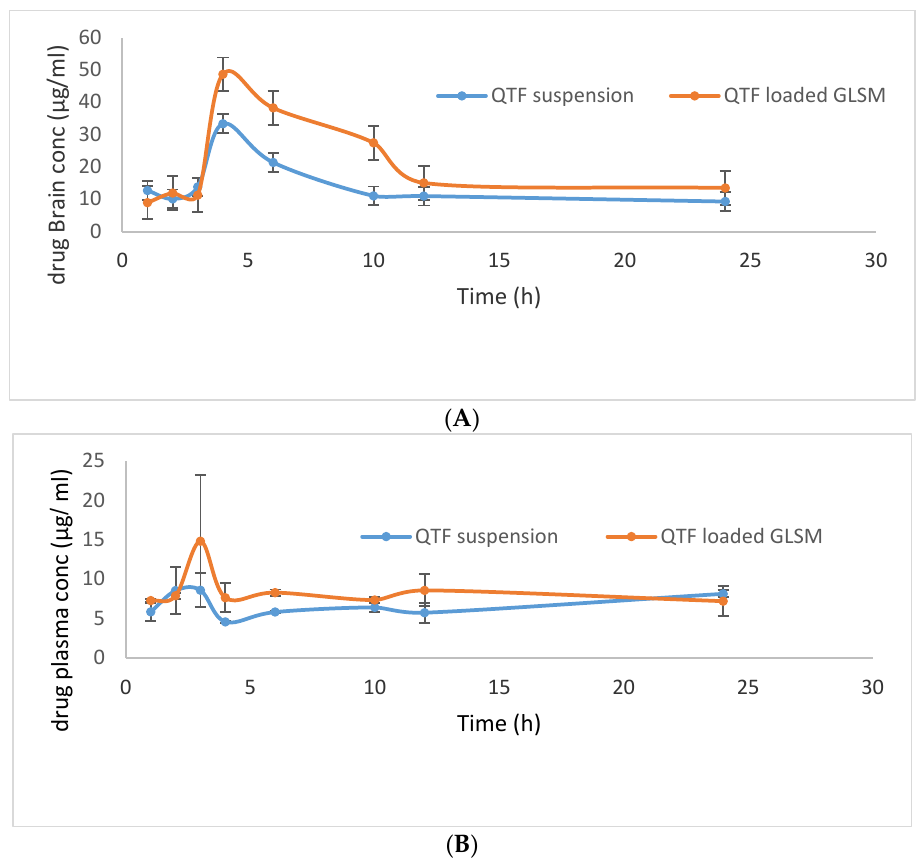
Figure 8. QTF mean brain concentration ( A ) and mean plasma concentration ( B ) after oral administration of QTF suspension, and QTF Loaded GLSMs.